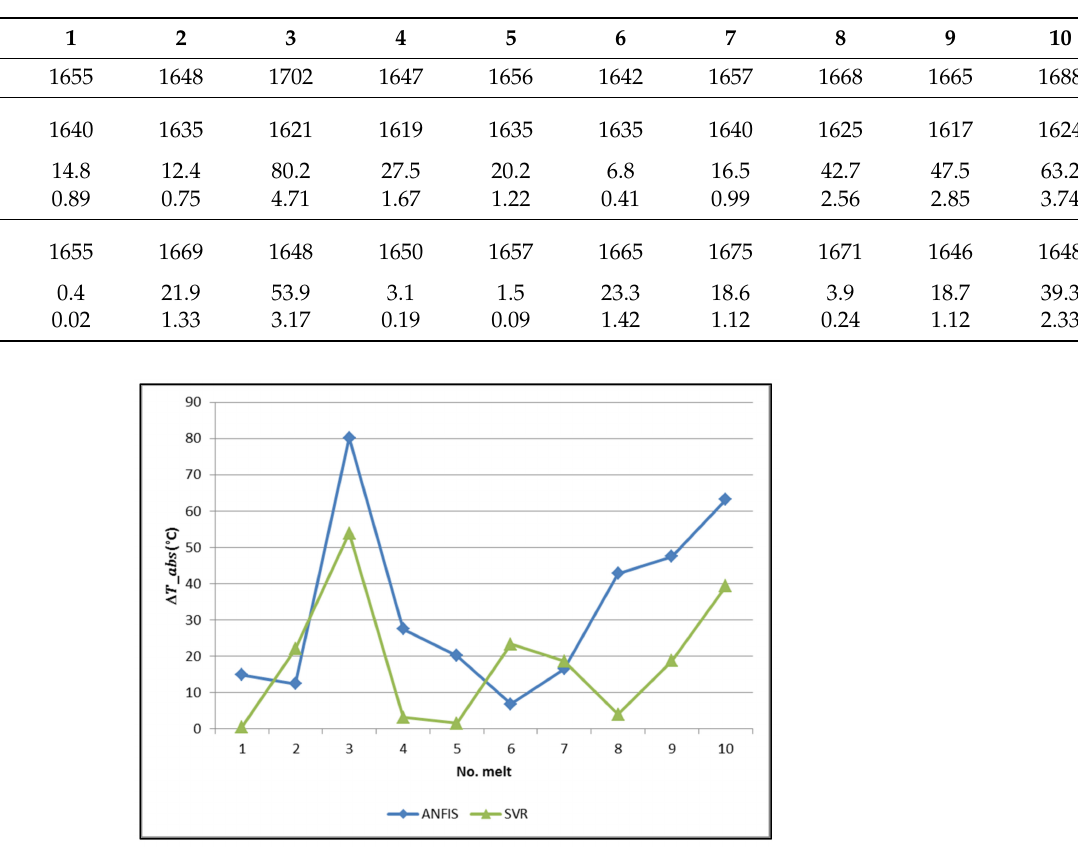
Table 4. The results of the machine learning models.